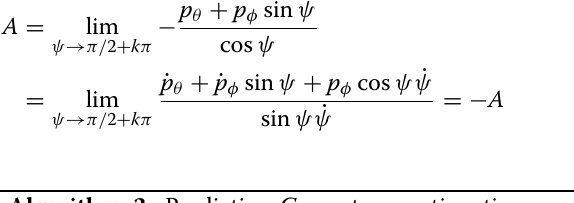
Algorithm 3: Prediction-Corrector